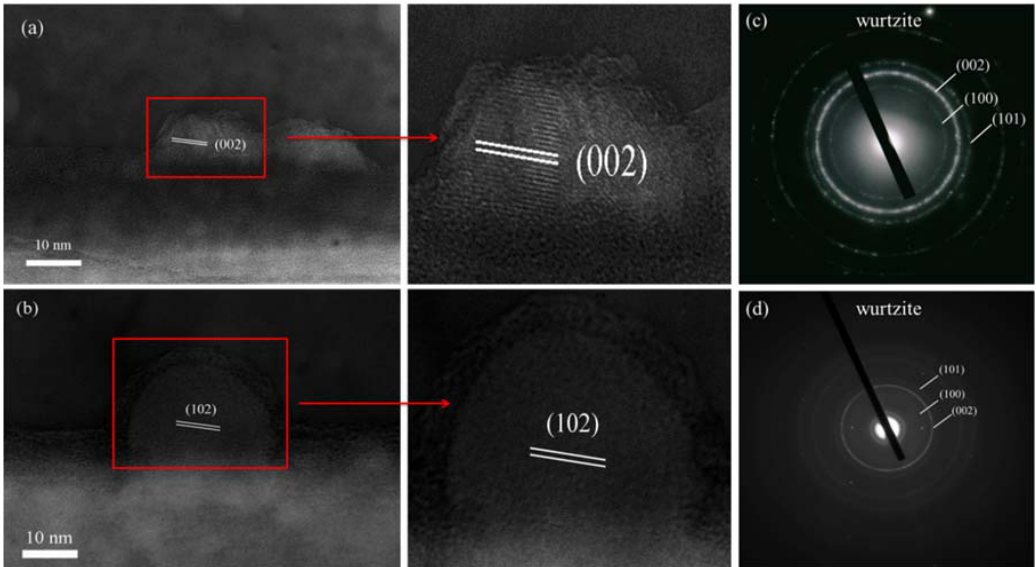
Figure 7. Cross ‐ section HRTEM images of a single GaN nanodot: sample C3 ( a ) and sample C4 ( b ); Selective ‐ area diffraction patterns of GaN nanodots: sample C3 ( c ) and sample C4 ( d ).